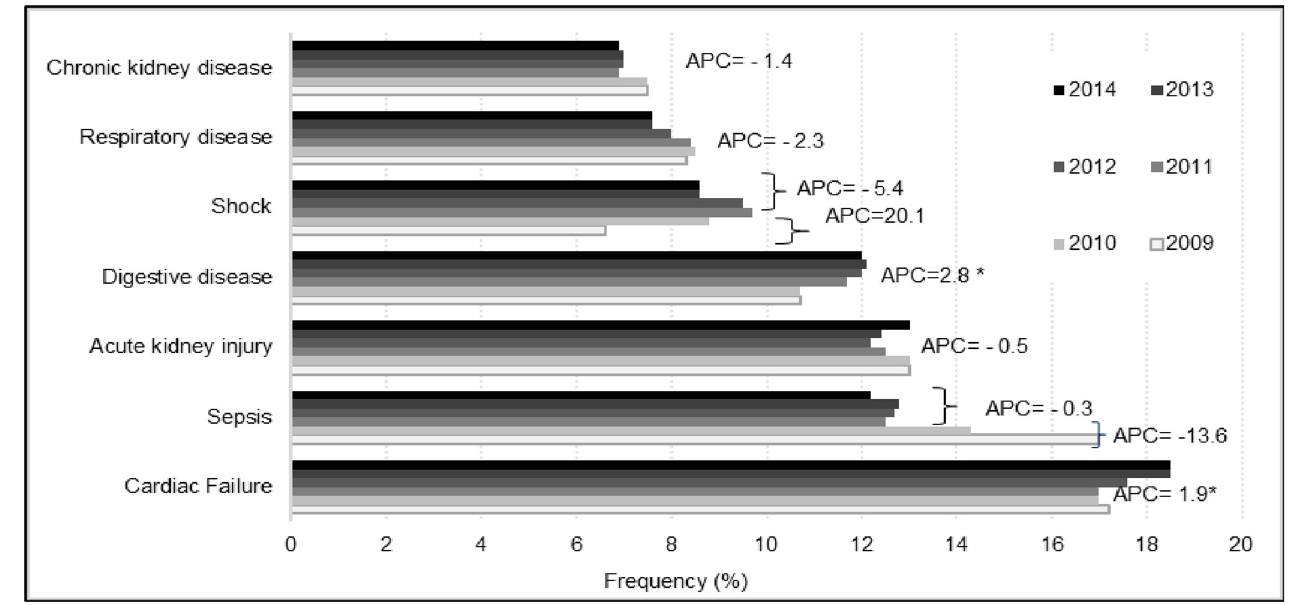
Fig 4. Trends in principal diagnoses of patients with AKI requiring dialysis from 2009 to 2014. � indicates that the Annual Percent Change (APC) is significantly different from zero at the alpha = 0.05 level.